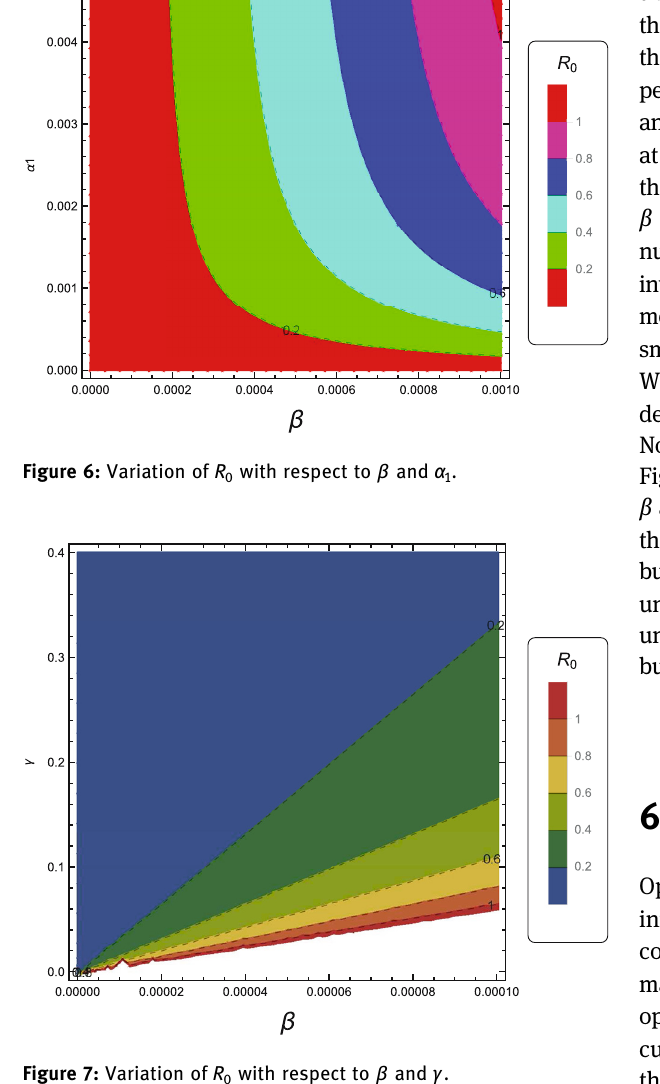
Figure 7: Variation of R 0 with respect to β and γ